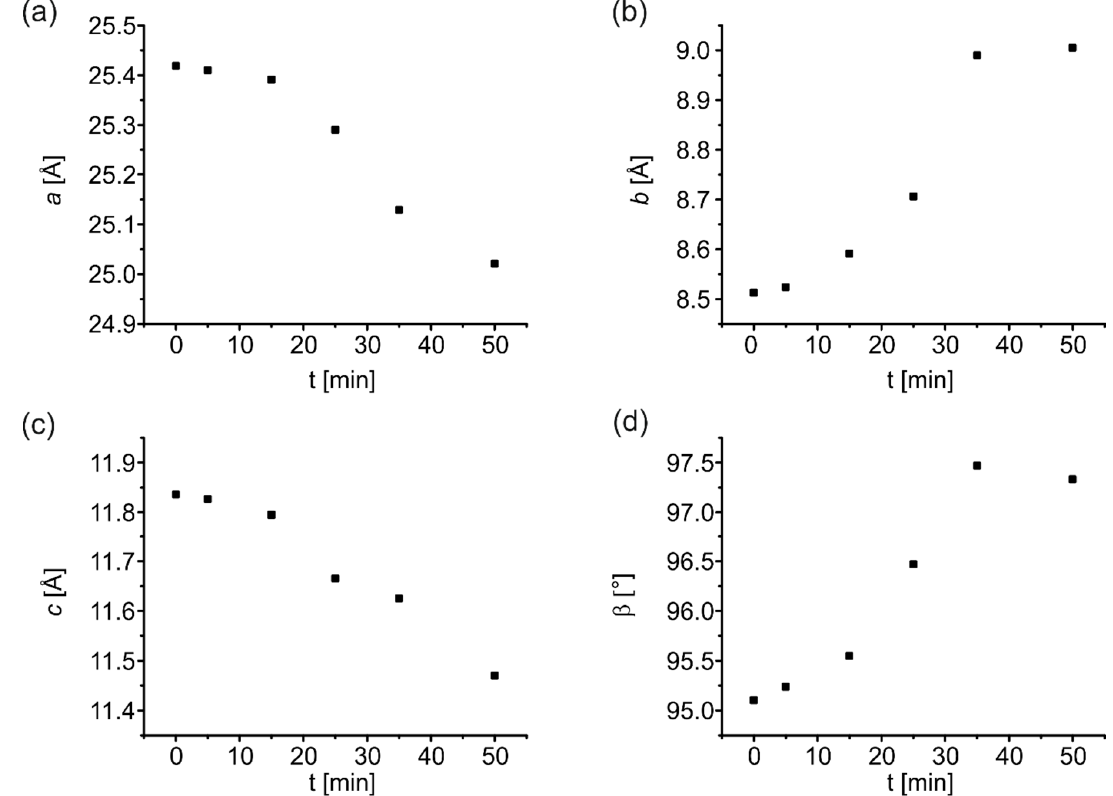
Figure 2. The variations in ( a ) a ; ( b ) b ; ( c ) c ; and ( d ) β for compound ( 1 ) at 0.1 MPa along with the time of UV irradiation. For a better comparison, the range of the y axis was set the same for plots ( a )–( c ). Table 2. The unit cell parameters for the irradiated crystals of ( 1 )–( 3 ).